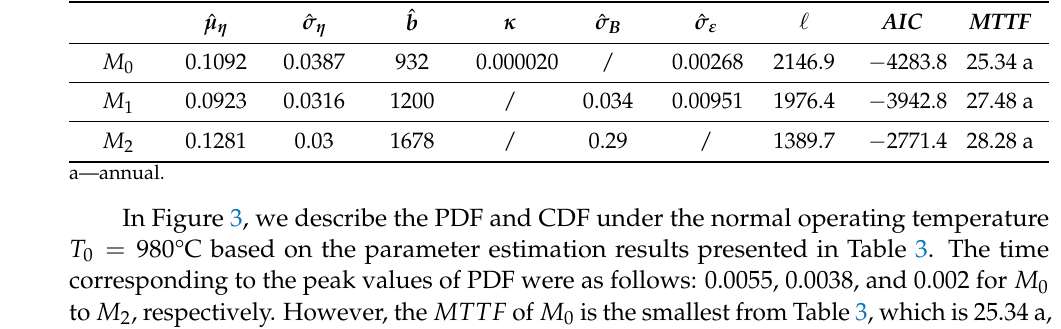
Table 3. The parameters of three degradation models with TWT CSADT degradation data.